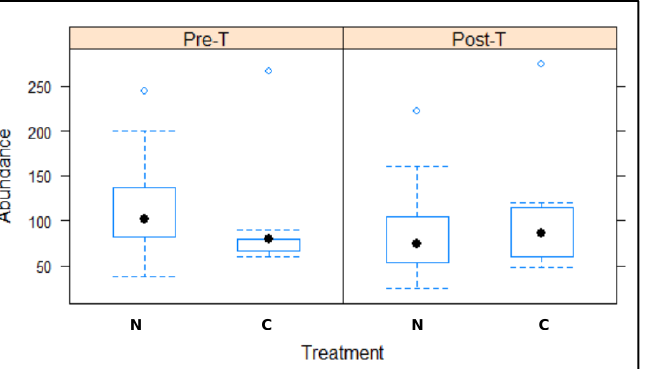
Figure 4. Differences in the average abundance of pigeons in each colony included as test (N, nicarbazin) and control (C) groups between the 2017 pre-treatment (Pre-T) and post-treatment (Post- T) periods.